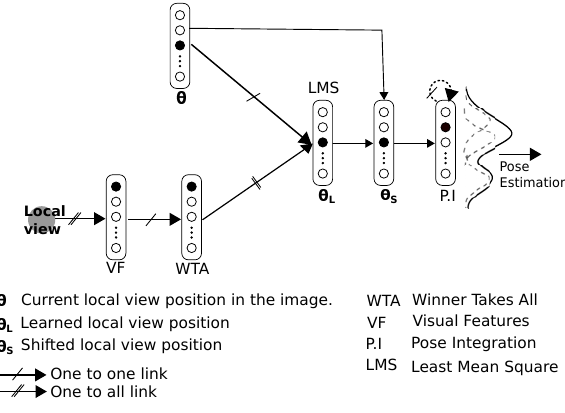
Figure 4: Architecture model for object pose